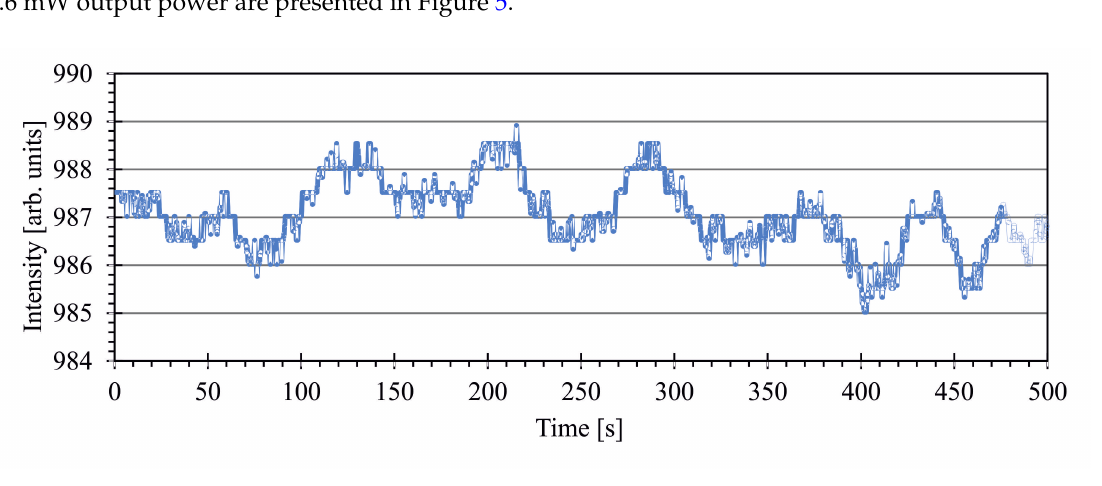
Figure 5. Drift of the optical power emitted by the tunable